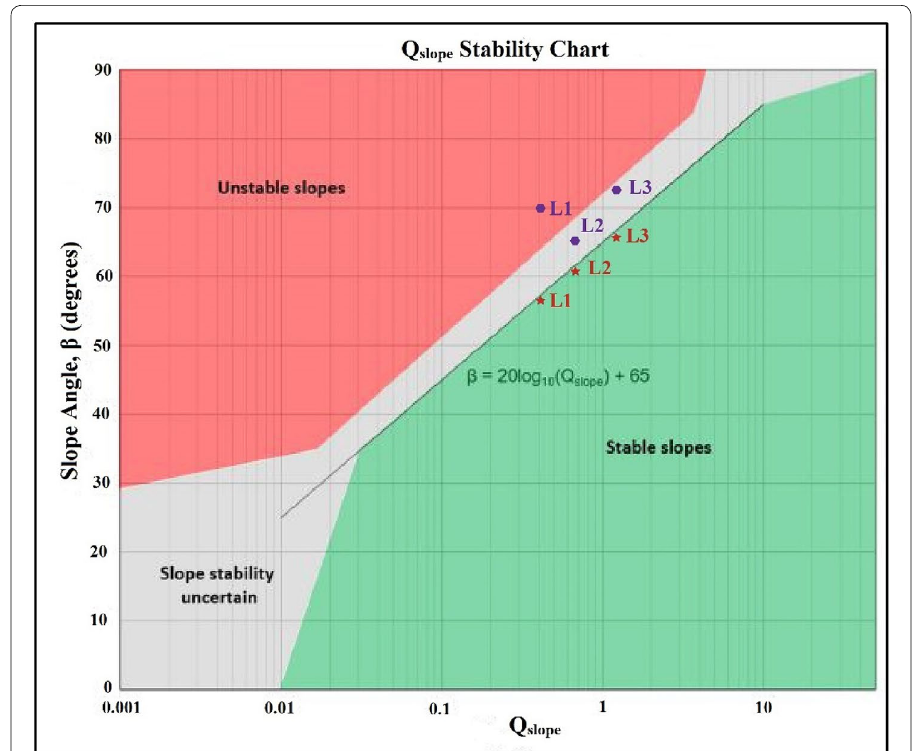
Fig. 5 Data plot of Q slope vs. average slope angle and β angles of the investigated cut slopes